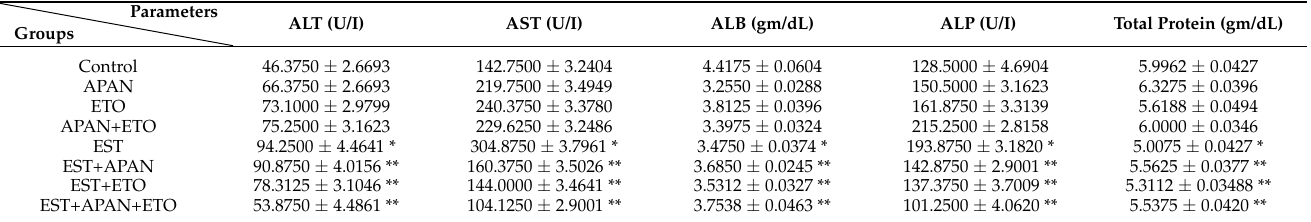
Table 5. Changes in serum liver